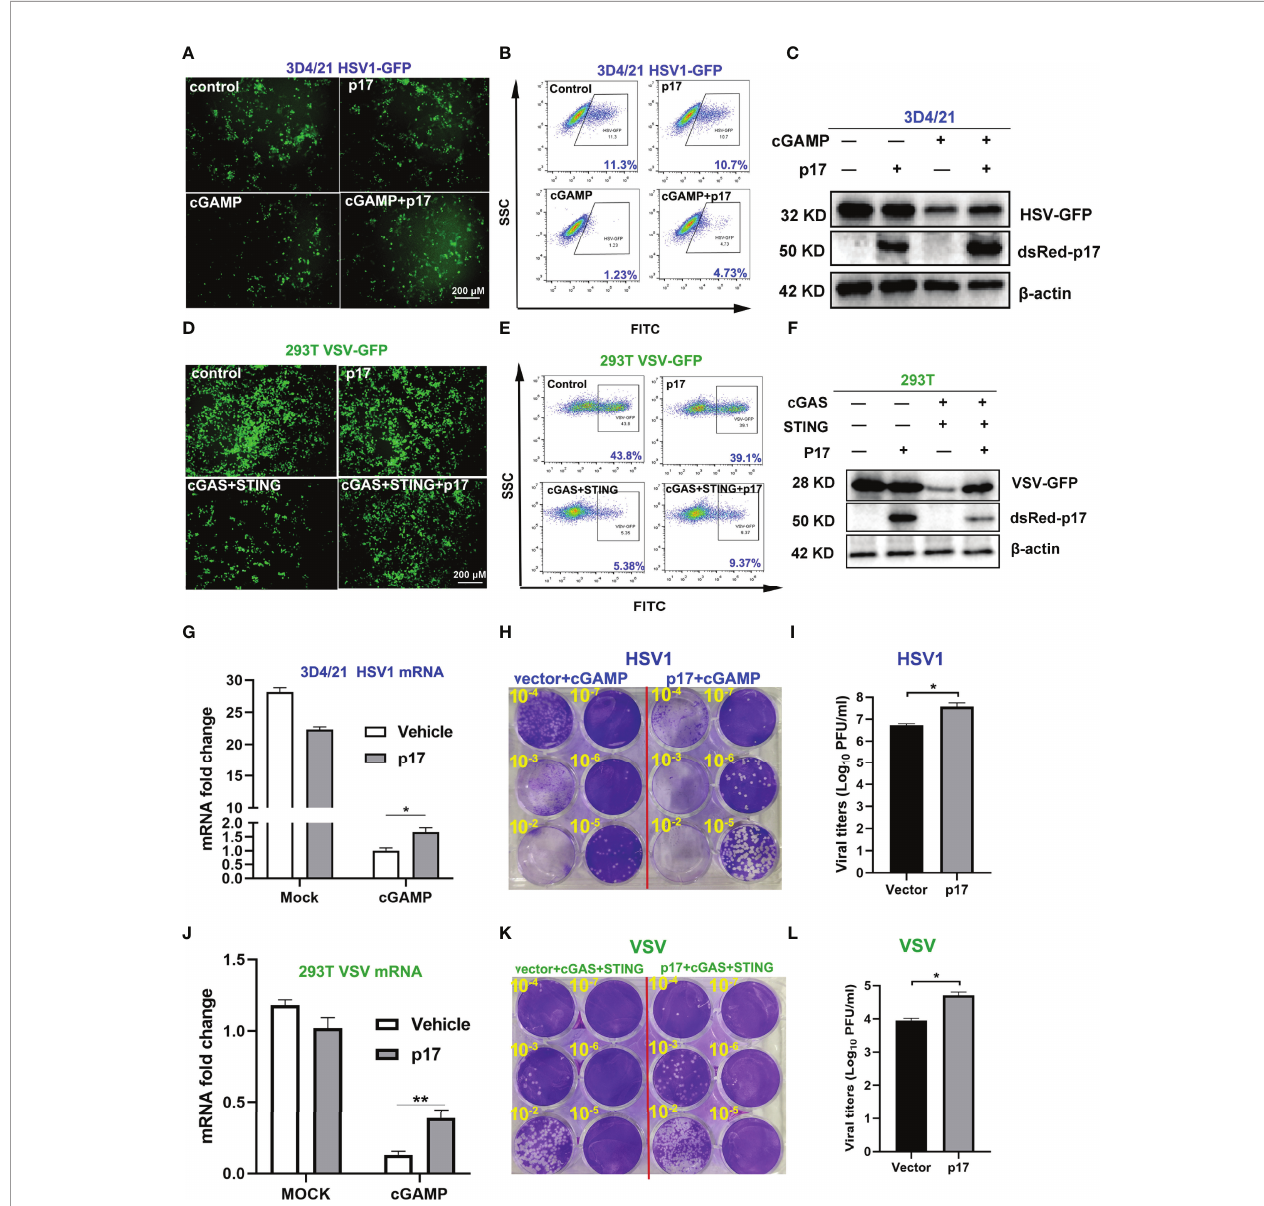
FIGURE 3 | The effects of p17 on the cGAS-STING signaling mediated anti-HSV1 and anti-VSV activity. (A-C, G-I) 3D4/21 cells grown in 12-well plates (3×10 5 cells/well) were transfected with pdsRed-p17 (1 m g) for 12 h, and next stimulated by transfection with 2 ’ 3 ’ -cGAMP (2 m g/mL) for 12 h. The cells were infected with HSV1-GFP at the MOI 0.01 for 20 h. (A) The HSV1 replicative GFP signals were observed by fl uorescence microscopy. (B) The HSV1-GFP infected cells were analyzed by fl ow cytometry. (C) The viral GFP expressions were analyzed by Western blotting. (G) HSV1 gB gene expressions were analyzed by RT-qPCR. (H) The viral titers in the supernatants from HSV1 infected 3D4/21 cells were analyzed by plaque assay. (I) The plaque numbers were quanti fi ed and graphed. (D-F, J-L) 293T cells grown in 12-well plate (3×10 5 cells/well) were co-transfected with pdsRed-p17 (0.5 m g), pcGAS (0.5 m g) and pSTING (0.5 m g) for 12 h, and then the cells were infected with VSV-GFP at the MOI 0.001 for 8 h. The VSV replicative GFP signals were observed by fl uorescence microscopy (D) , analyzed by fl ow cytometry (E) , and by Western blotting (F) . The VSV glycoprotein genes were analyzed by RT-qPCR (J) and the VSV titers in supernatants from VSV infected 293T cells were measured by plaque assay (K) . The plaque numbers were quanti fi ed and graphed (L) . * P <0.05, ** P